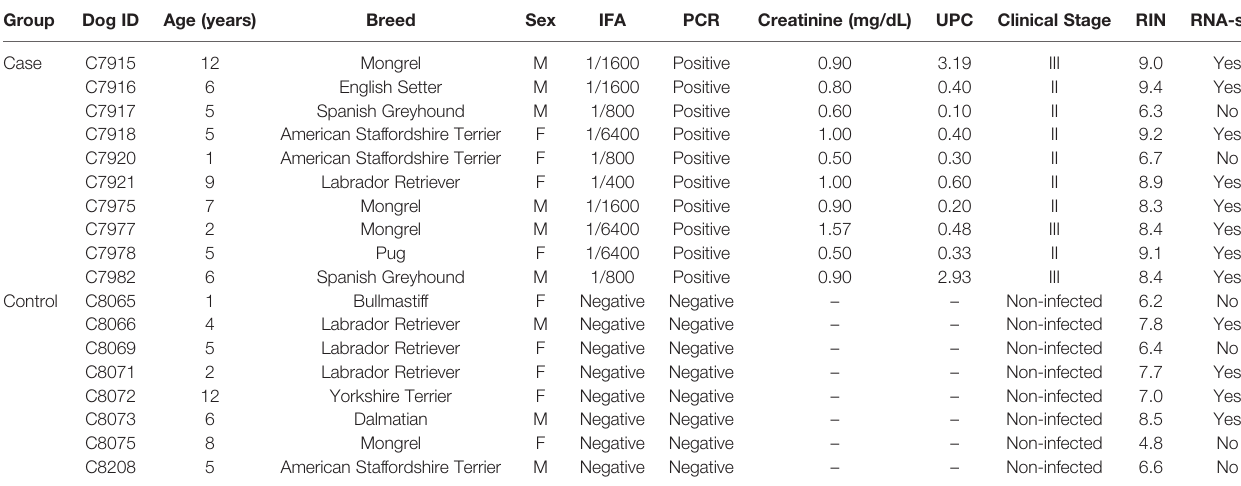
TABLE 1 | Clinical data for enrolled cases and controls. Group